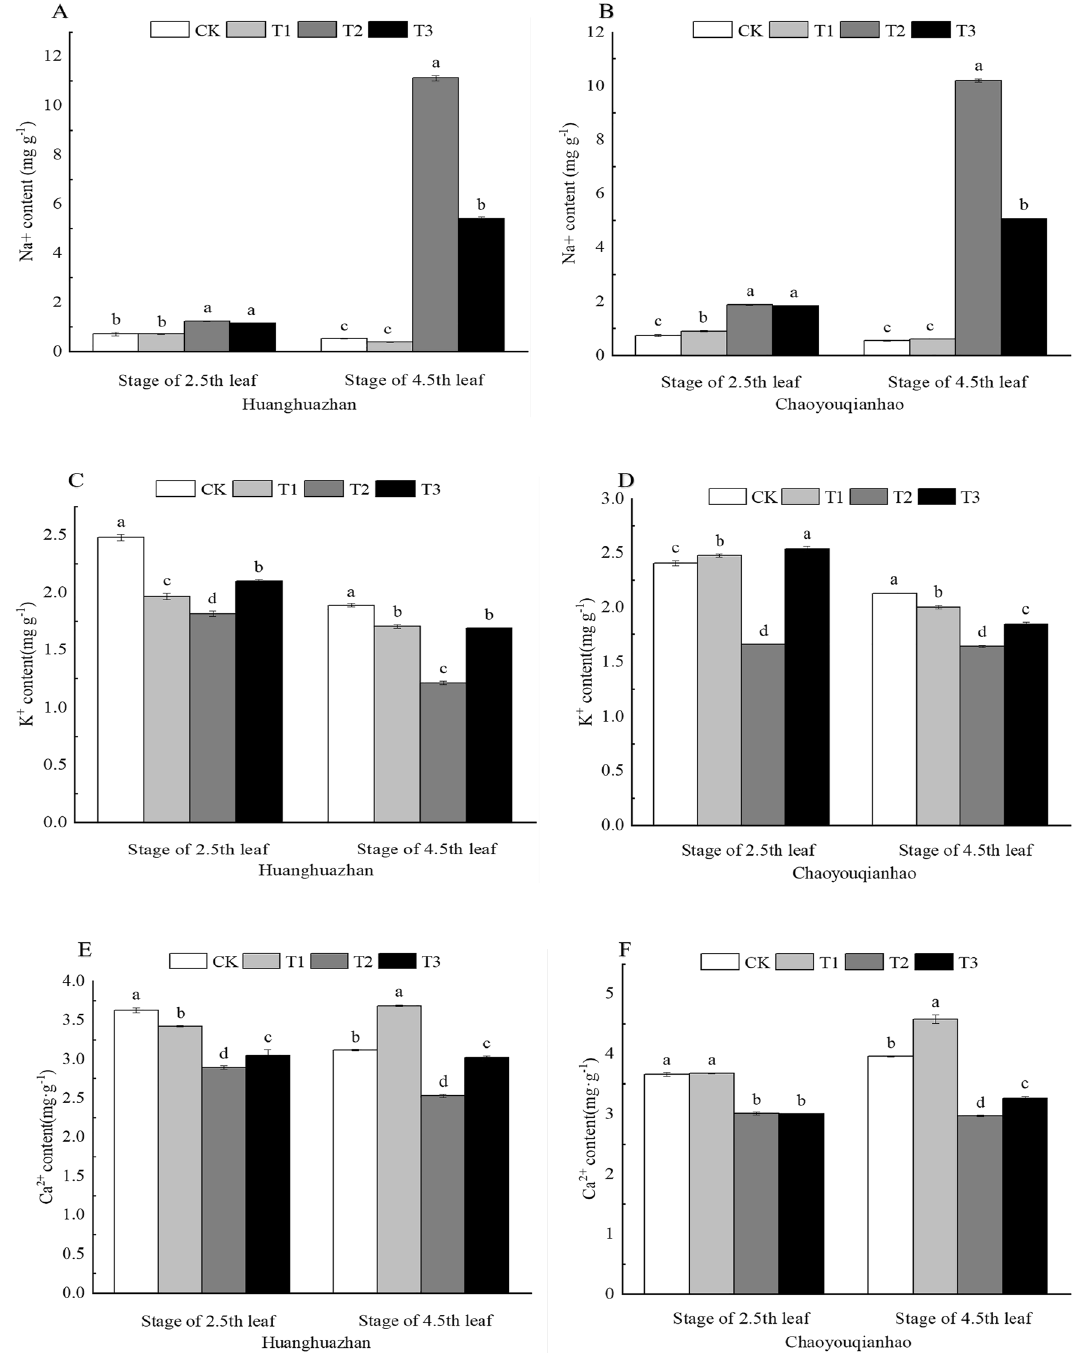
Figure 8. Effects of soaking of BR on Ion content of rice seedlings under salt stress. Different lowercase letters indicate significant differences at the P < 0.05 level. CK: soaking with distilled water + watering 0 g L −1 NaCl. T1: soaking with BR + watering 0 g L −1 NaCl. T2: soaking with distilled water + watering 3 g L −1 NaCl. T3: soaking with BR + watering 3 g L −1